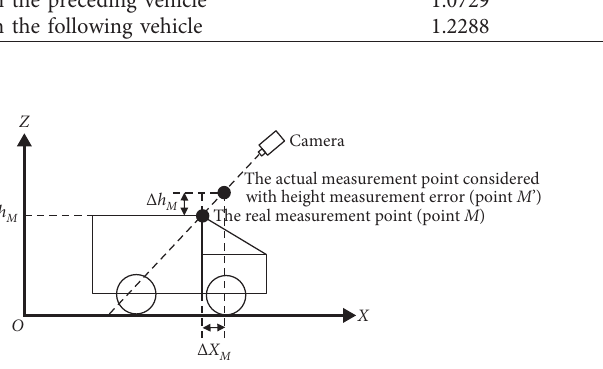
Figure 10: Space headway error caused by measurement point height measurement error.